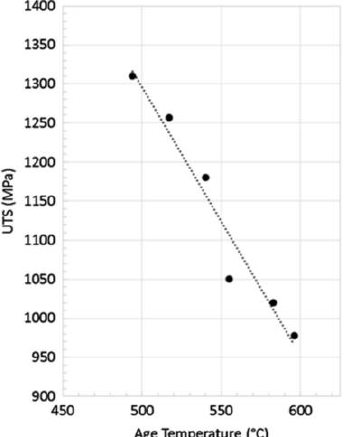
Figure 12. Ultimate tensile strength (UTS) as a function of aging temperature for the near-beta Ti-10V-2Fe-3Al (wt. %) alloy. The alloy was solution-treated at 750 °C (1385 °F) for 8 h, water-quenched and then isothermally aged [106]. (Reprinted by permission from Metallurgical Transaction A, vol. 18, no. 12, R. R. Boyer and G. W. Kuhlman, Processing properties relationships of Ti-10V-2Fe-3Al, 2095–2103, 1987, with permission from Springer Nature).